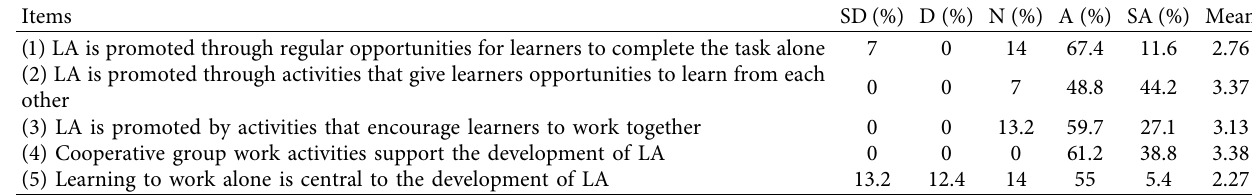
Table 5: Descriptive statistics of the social orientation of autonomy.